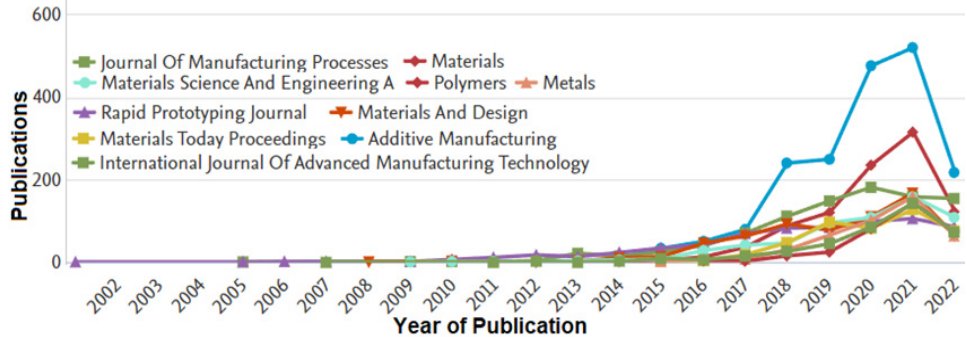
Figure 8. The number of publications per year by source against years of publication for publications from 2001 to 2022 (data retrieved from the Scopus database on 20 June 2022).